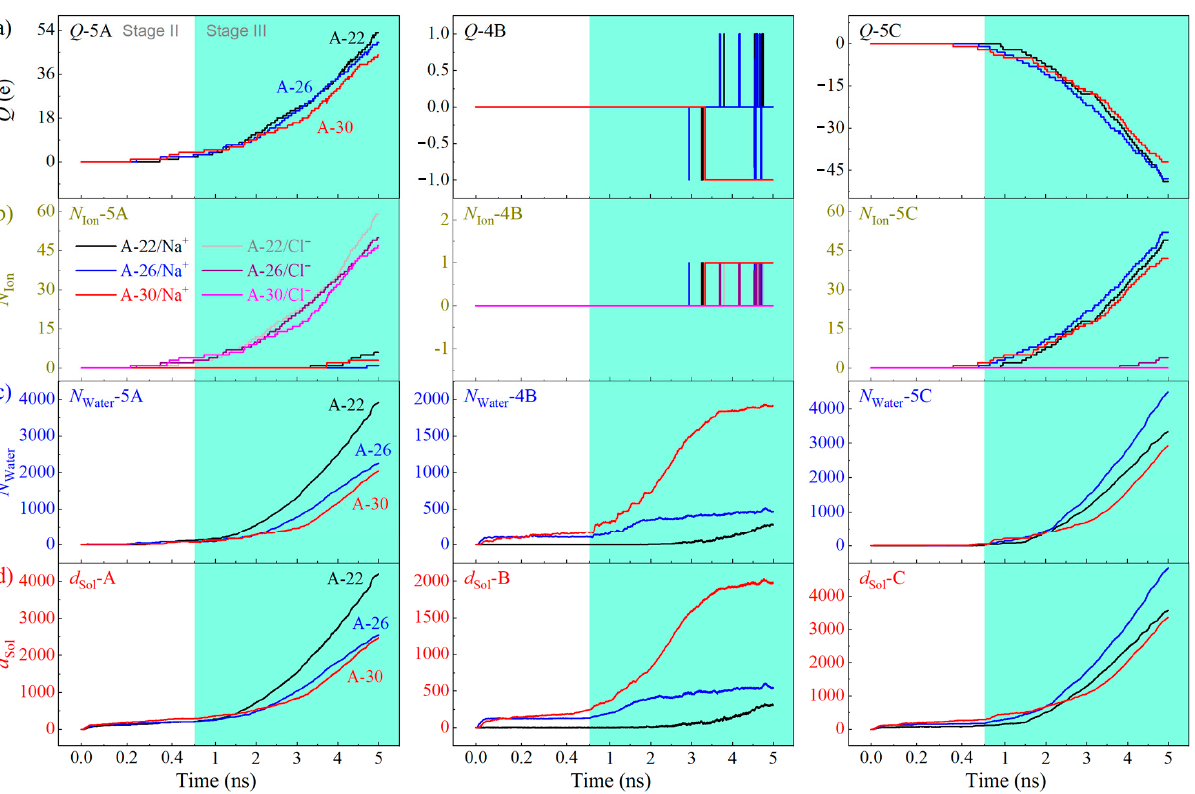
Figure 7. Physical quantities of the solution with C NaCl = 0.6 mol/L flowing through the three different CTT nanochannels when E EF = 6.9 V/Å. ( a ) Electric charges in the three containers, ( b , c ) the numbers of ions and water in the three containers, and ( d ) the discharge of solution via the three subchannels in each CTT.